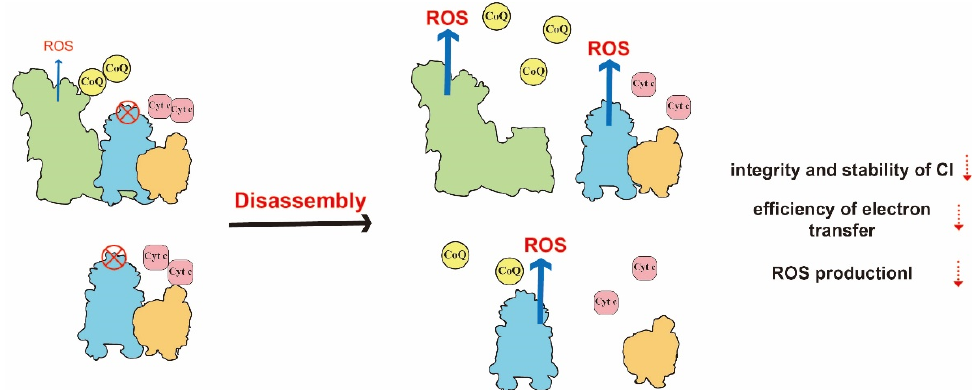
Figure 4. Illustration of the dysfunction of the respiratory chain induced by the disassembly of SCs. With the defect of CIII as an example, the failed assembly of SCs results in a longer diffusion distance decreased efficiency of electron transfer, and increased ROS production. In addition, the stability of CI is reduced.